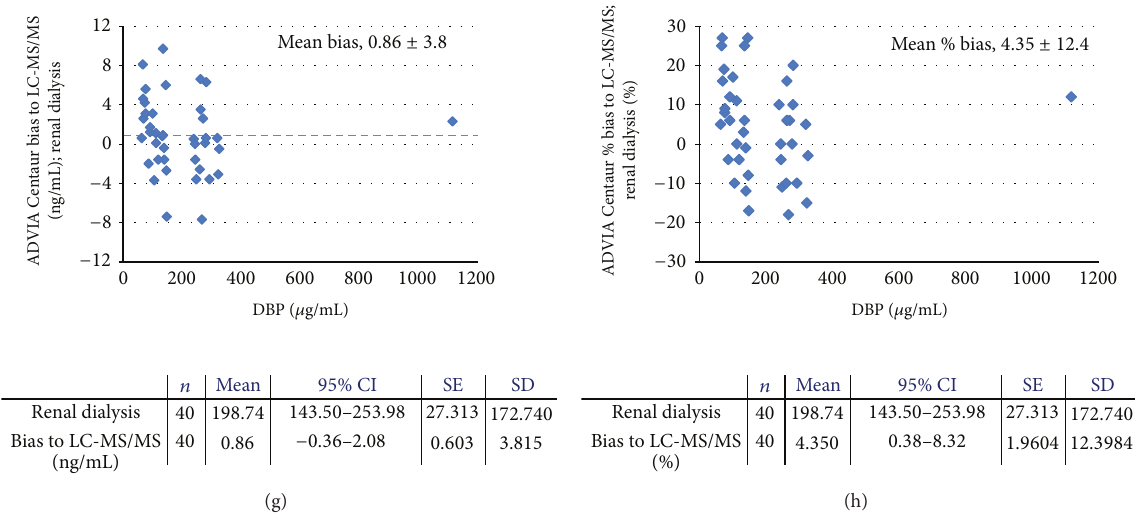
Figure 1: Bias and percent bias between the 25(OH)D results of the ADVIA Centaur Vitamin D Total assay and the LC-MS/MS method as a function of DBP concentration in healthy human serum pooled samples (endogenous and endogenous + spiked) (a, b, c, d), pregnancy (third trimester) samples (a, b, e, f), and renal dialysis samples (a, b, g, h). The bias ± 1.96 standard deviation (SD) represents the 95% limits of agreement. To convert 25(OH)D concentrations to nanomoles per liter (nmol/L), multiply by 2.5.